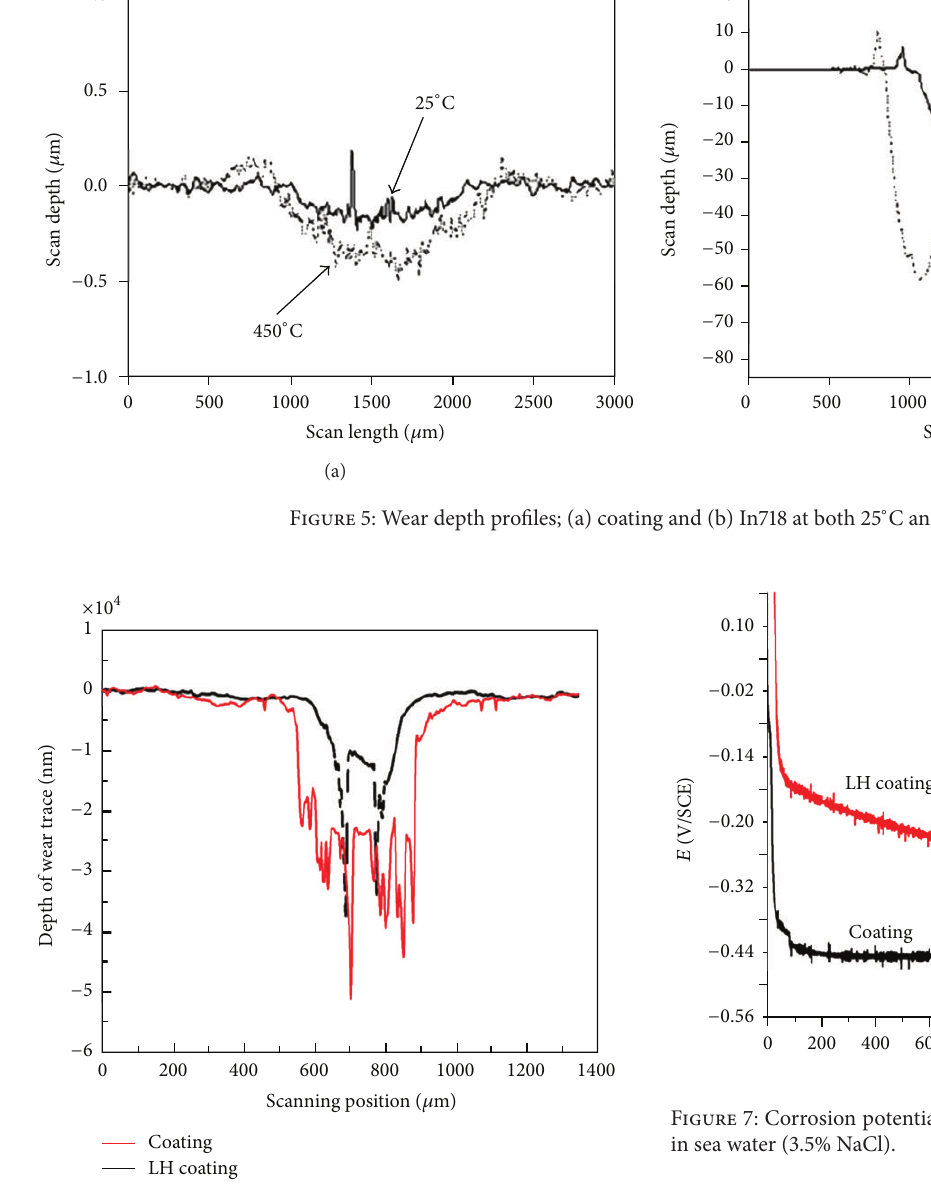
Figure 6: Wear depth profiles of coating and LH coating at room temperature.